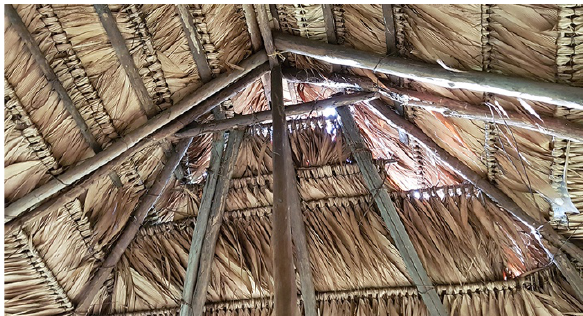
Figure 12. Free space at the upper end of the gable for ventilation, in a building in Guabo de Yorkin (Bribri area).